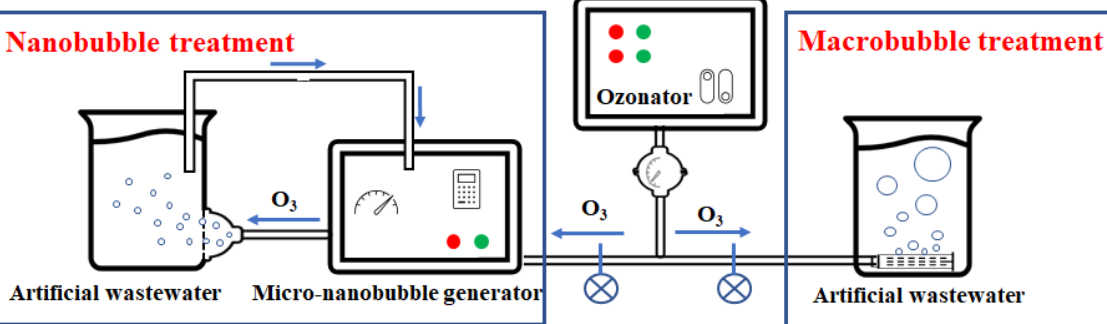
Figure 1. Schematic of the experimental setup.